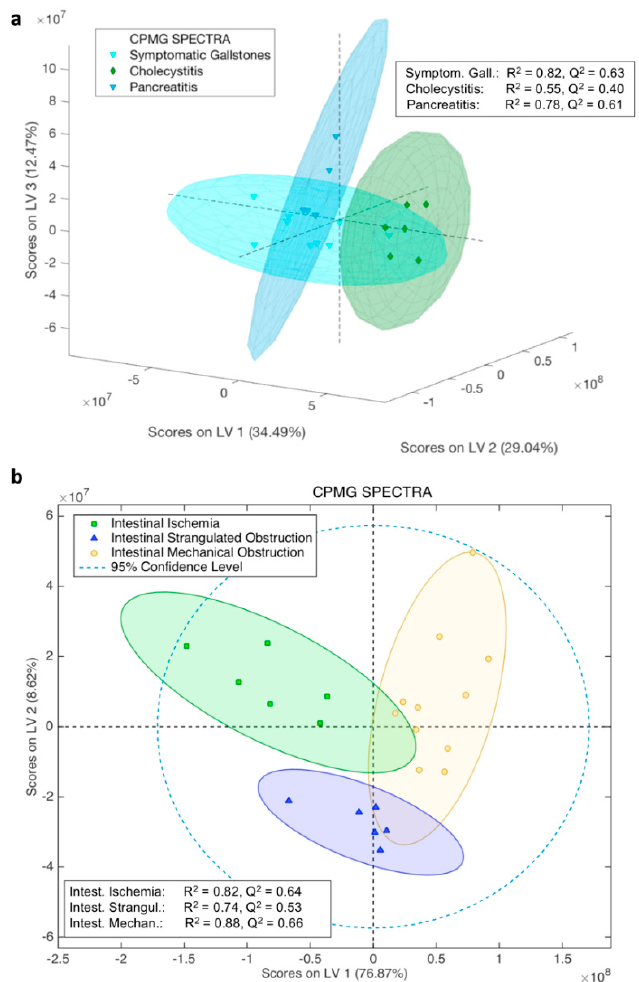
Figure 5. 3D and 2D score plots of the OPLS-DA classification of: ( a ) symptomatic gallstones, cholecystitis, and pancreatitis; ( b ) of intestinal ischemia, intestinal strangulated obstruction, and intestinal mechanical obstruction cases, respectively, along with R 2 and Q 2 values. OPLS-DA models are derived from serum 1 H-NMR CPMG spectra. The 3D score plot has been constructed after the analysis of the serum spectra and the three first latent variables (LVs) components were used (the third one is the orthogonal component), which were also used for the final model production, since after the third component the mean classification error in the model was increasing (Figure S5b). Extra viewing angles of the 3D score plot from the CPMG spectra model are depicted in Figure S7. Except for the three groups samples distribution, the 95% confidence ellipse of each group is depicted. Table 2. Cross-Validation results (confusion matrices) and accuracies from the OPLS-DA analysis of the CPMG NMR spectra for symptomatic gallstones, pancreatitis, and cholecystitis. Predicted/Diagnosed Symptomatic Gallstones Cholecystitis Pancreatitis CPMG SPECTRA (Cross validation) Predicted as Symptomatic